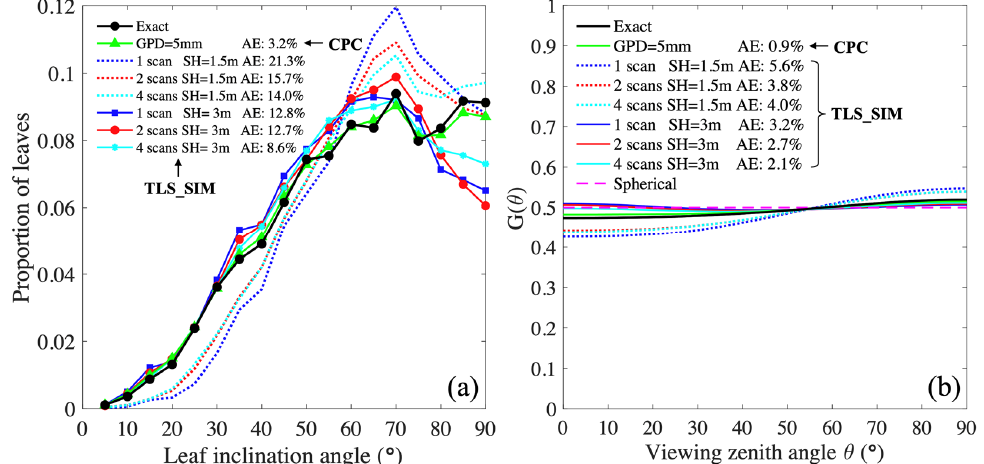
Figure 6. The effect of the number of scans and the scanner height on the leaf angle distribution (LAD) ( a ) and the G-function ( b ) for Tree2: the “Exact” curves in black are the true LAD and the G-function computed from the three-dimensional (3D) tree model, respectively; the green curves are the LAD and G-function computed from the complete point clouds (CPC) with a grid point distance (GPD) of 5 mm, which can represent the accuracy of the method without the occlusion effect; TLS_SIM denotes simulated TLS point clouds. The scanning strategy is illustrated in Figure 1(d2).